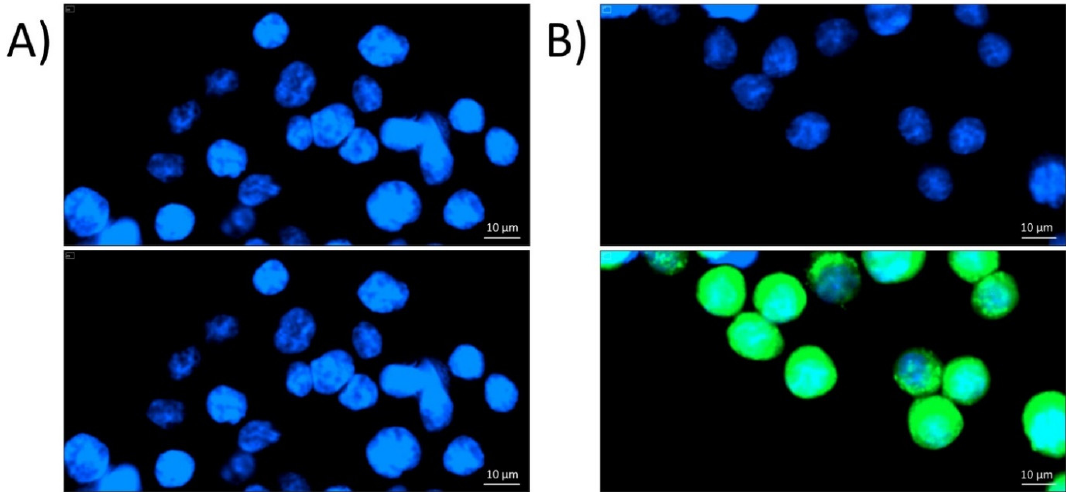
Figure 2. Fluorescence images of HT-29 cells after 1 h incubation with either the solvent control ( A ) or 50 µM P8-D6 ( B ), taken with a BioTekTM CytationTM3. The upper pictures show just the nuclear staining with Hoechst 33258, pictures at the bottom show a combined image of nuclear staining and P8-D6 auto-fluorescence at 525 nm.